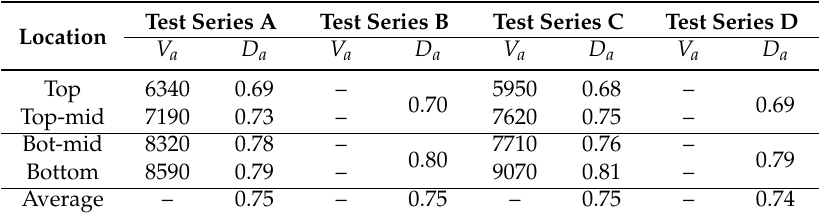
Table 6. Aggregate volume concentration for four test series A, B, C, and D.